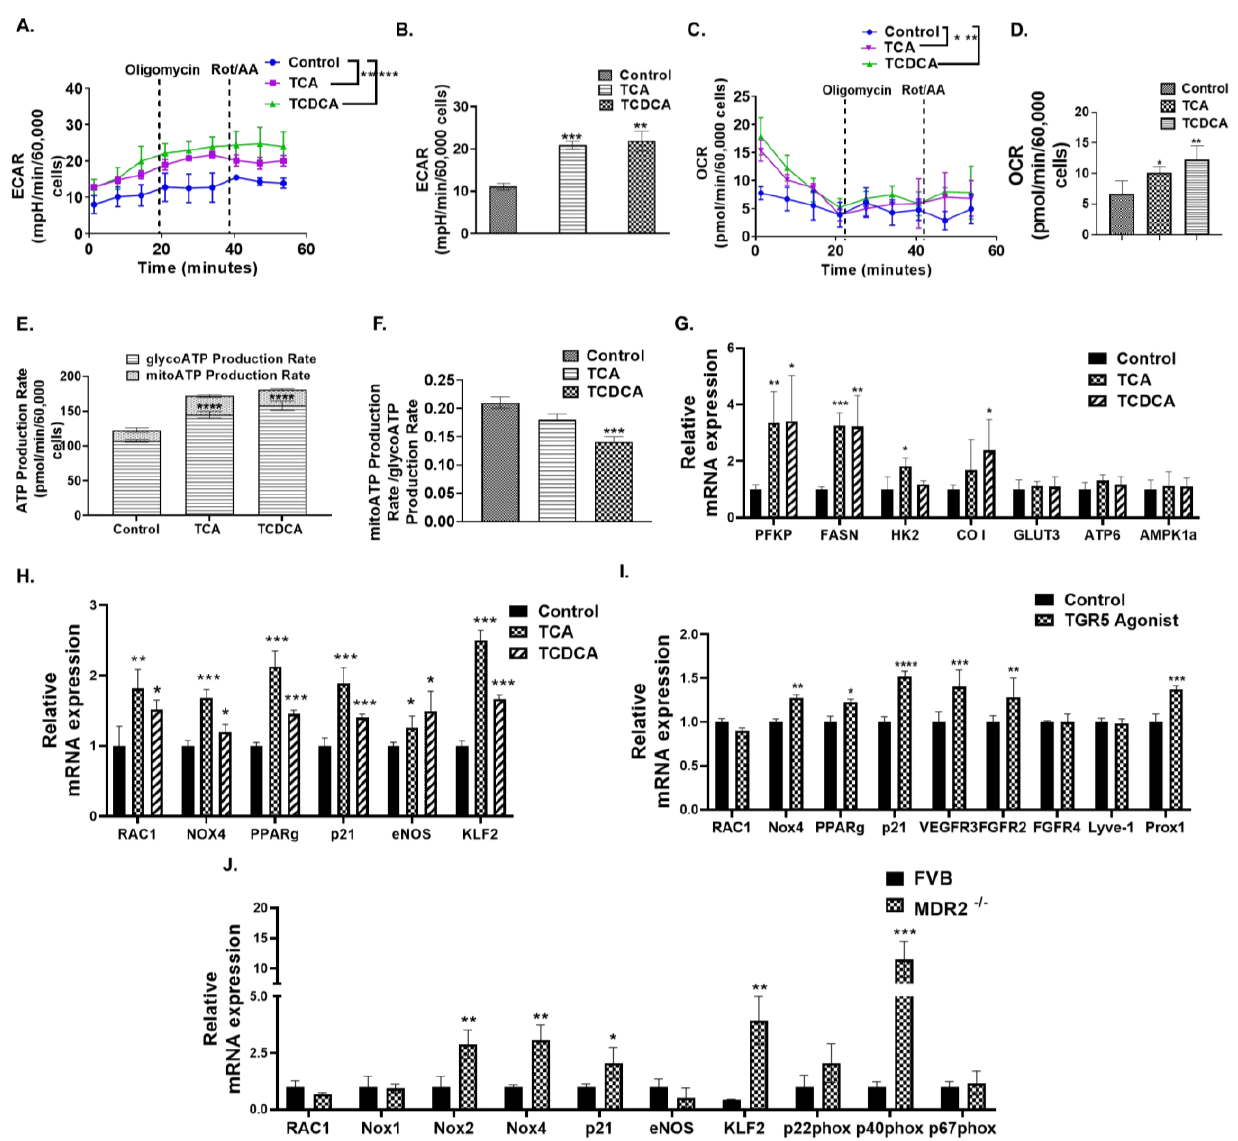
Figure 4. Conjugated BAs alters cellular metabolism and enhances expression of genes involved in the Redox pathway. ( A – F ) Conjugated BAs alter the cellular metabolism in HLECs. The extracellular acidification rate (ECAR) of control and conjugated BAs (TCA and TCDCA) (100 µM)-treated groups were measured by Seahorse XFp Cell Energy Phenotype Test Kit and plotted using the Wave software. The ECAR was represented at time points after sequential addition of oligomycin (1.5 µM) and Rot/A.A. (0.5 µM). The basal oxygen consumption rate (OCR) was significantly increased by conjugated BAs. Values are represented as mean ± SD, n ≥ 3. ** p ≤ 0.01 represents value significantly different than control. ( E , F ) The comparison between glycolytic and mitochondrial ATP production rate in 5% EGM, TCA, and TCDCA (100 µM) treated HLECs showed that conjugated BAs (100 µM) increased the glycolytic ATP production rate in HLECs. ( G ) Conjugated BAs also increased the mRNA expression of the metabolic genes PFKP, HK2, CO I , and FASN . ( H ) Conjugated BAs induced the mRNA expression of the redox genes RAC1, Nox4, PPARγ , p21CIP, eNOS , and KLF2 in HLECs after 24 h of treatment in 5% EGM. ( I ) The TGR5 agonist (2.5 nM) treatment for 24 h increased the mRNA expression of growth factor receptors and redox genes in HLECs. ( J ) The mRNA expression of the redox genes p40phox, Nox2, Nox4, KLF2 , and p21 were also significantly high in the lymph node of Mdr2 − / − mice compared to the control (FVB) mice. Data are represented as mean ±SD. n ≥ 3. One-way ANOVA followed by Fisher LSD was used for multiple comparison. *, ***, **** indicates p ≤ 0.05, p ≤ 0.001, p ≤ 0.0001, respectively, as compared to respective control.